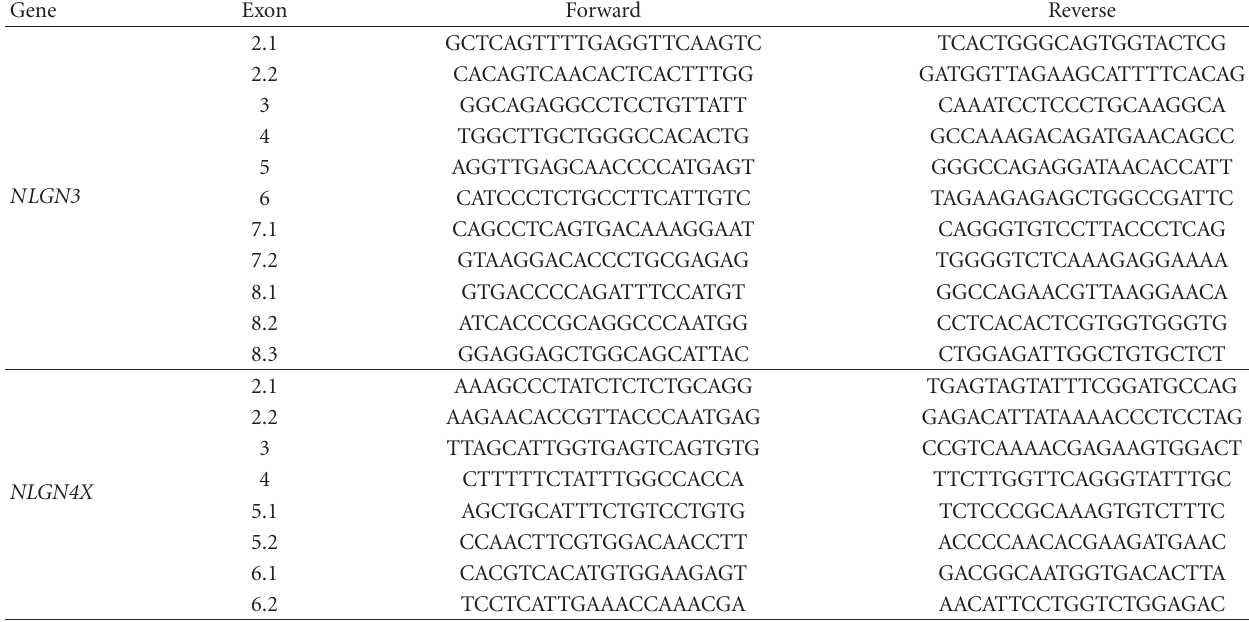
Table 2: Primer sets used to screen for variants by PCR-HRM